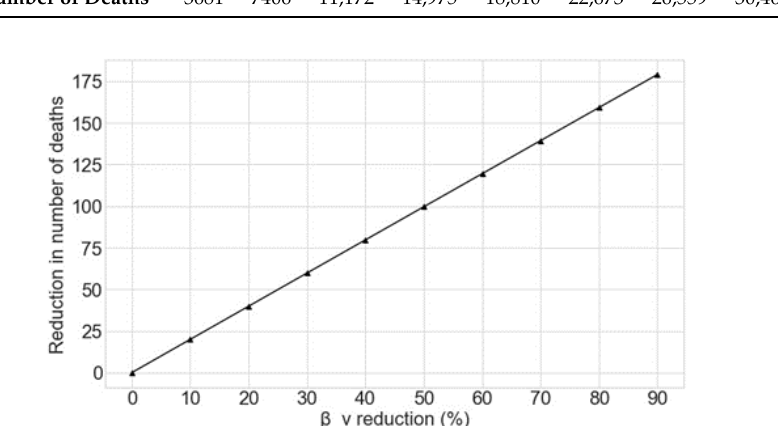
Figure 8. Reduction in the number of deaths as a function of the percentage decrease in β v for the best fit model, given that this reduction is applied from June 2020.